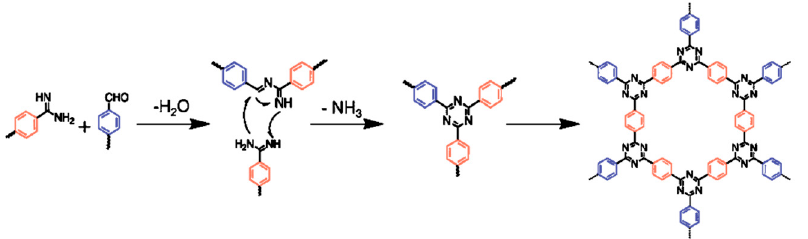
Figure 5. Polymerization of CTF-1 via a condensation reaction between an aldehyde and an amidine dihydrochloride over Cs 2 CO 3 [23].